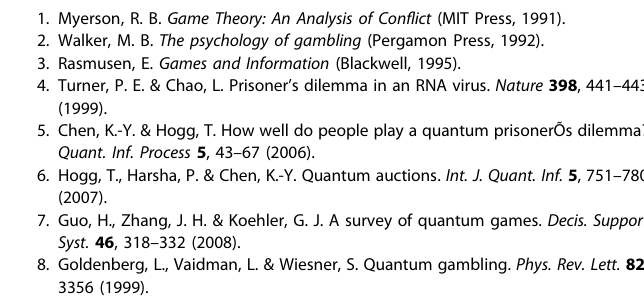
Fig. 2 Experimental demonstration of quantum gambling. Two 1-mm thick β -barium borate crystals (BBO1 and BBO2) located side by side and the BBO2 is rotated 180° around the pump direction, so the photon pairs generated are in polarization state | H 〉 | V 〉 for BBO1 and in | V 〉 | H 〉 for BBO2. HWP indicates the half-wave-plate and PBS is the acronym for polarized beam splitter, which transmits horizontally polarized light and re fl ects vertically polarized light. HWP1 and PBS1 are used to project the state of idle photon into photon will be prepared in the form of Eq. (1). So the parameter α can be controlled with rotating HWP1 by Alice. Two calcite beam displacers (BD1 and BD2) construct a polarization interferometer, which is instinct stable. HWP2 at 45° swaps the polarization and HWP3 realizes the parameter γ for Bob. HWP4 and PBS2 are used to check the state to be committed state or not. The three probabilities P 1 , P 2 , and P 3 are gotten from the coincident counts of D1&D2, D1&D3, and D1&D4, respectively, where D represents the single-photon